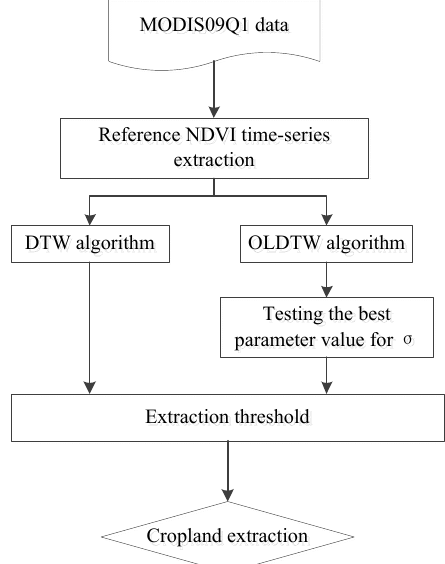
Figure 4. Flow chart of the experiment. To test whether the OLWDTW algorithm is more